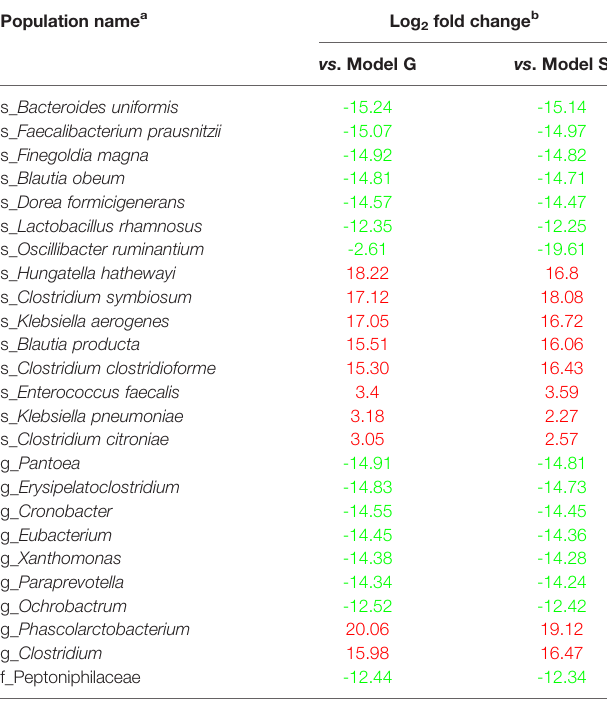
TABLE 2 | Differential abundance analysis of model T, compared to models G and S, at day 38. Population name